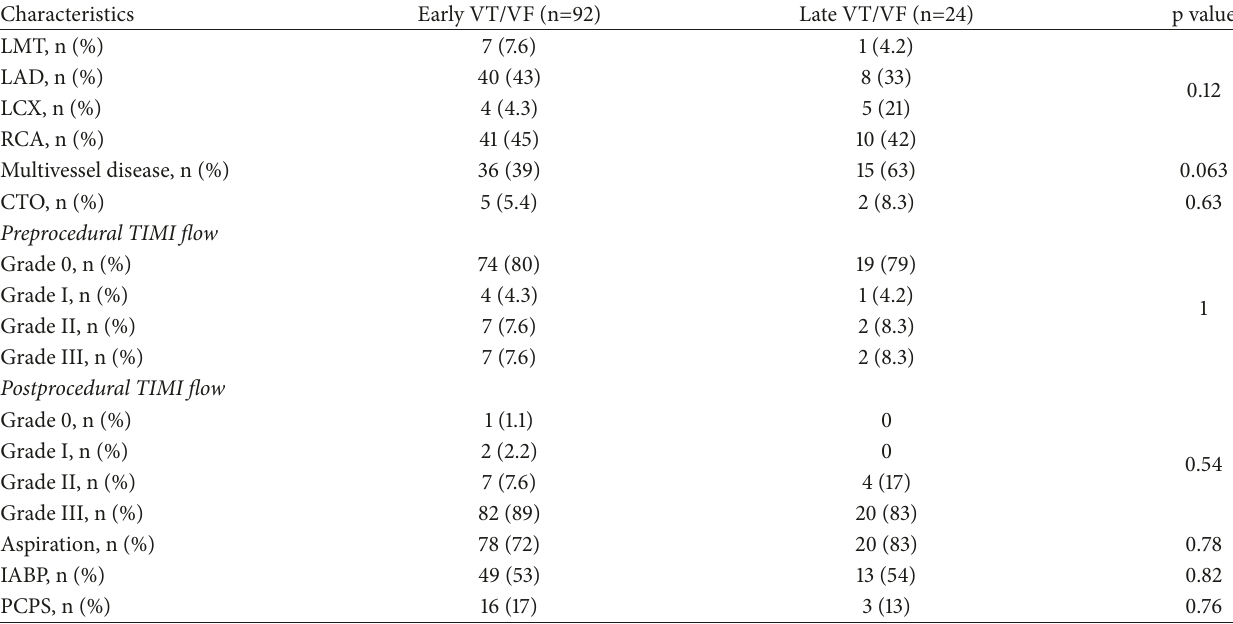
Table 2: Angiographic findings of the patients with early VT/VF or late